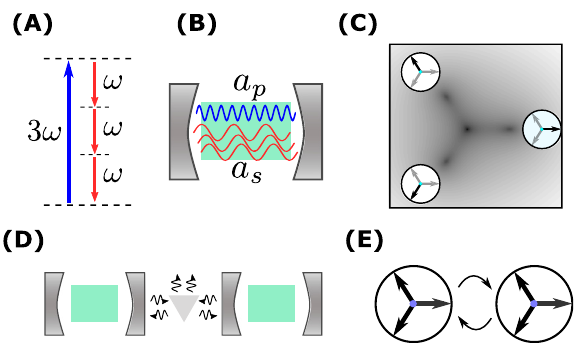
Figure 1: (A) A schematic illustration of the 3PDC process with a virtual energy diagram. (B) A parametric 3PDC oscillator implemented in a Fabry-Pérot cavity. (C) The ternary phase of the 3PDC oscillator operating above the threshold depicted in the in- phase and quadrature-phase coordinates. (D) Dissipative coupling of two 3PDC oscillators. (E) A two-spin Potts system. 3PDC, three- photon